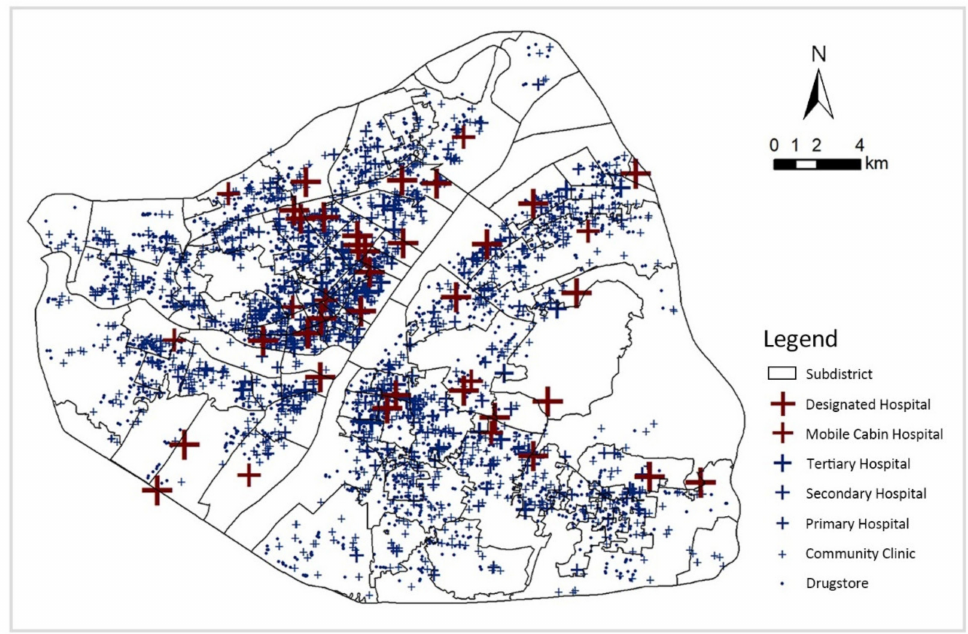
Figure 3. Distribution of seven types of medical facilities in